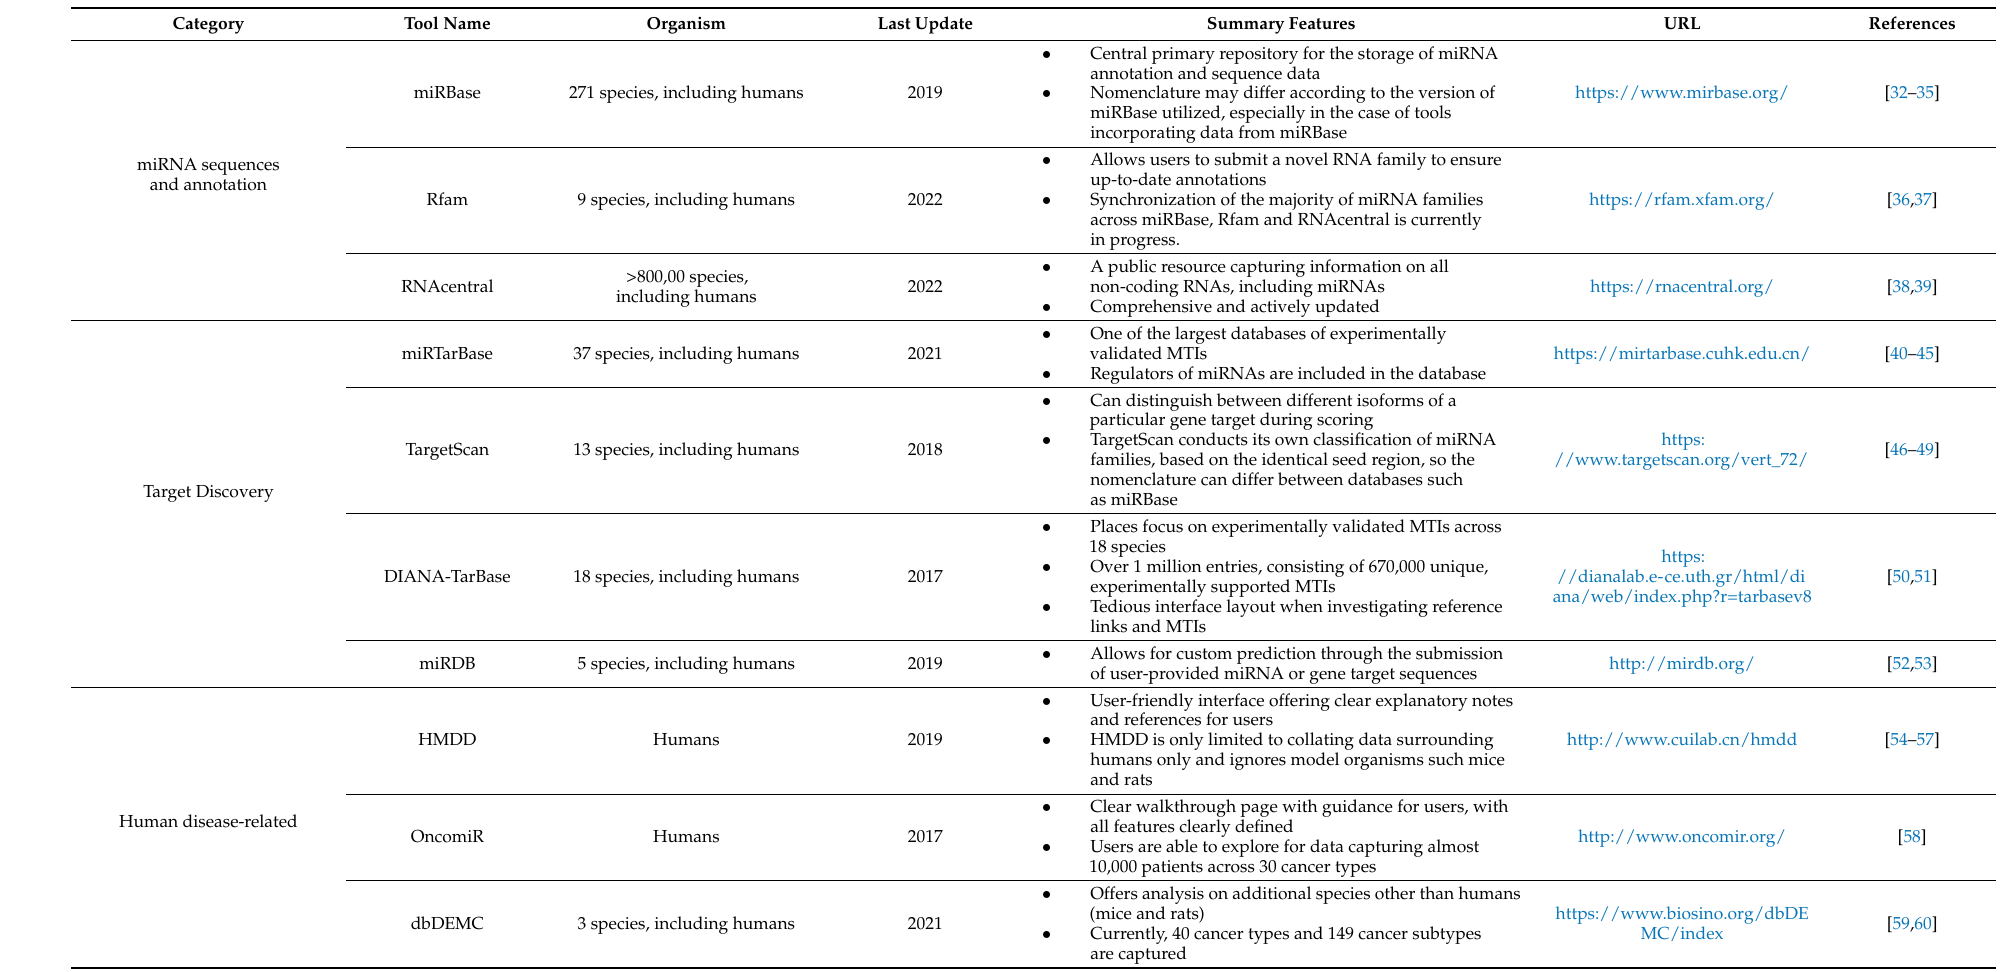
Table 1. Overview of described tools available for miRNA